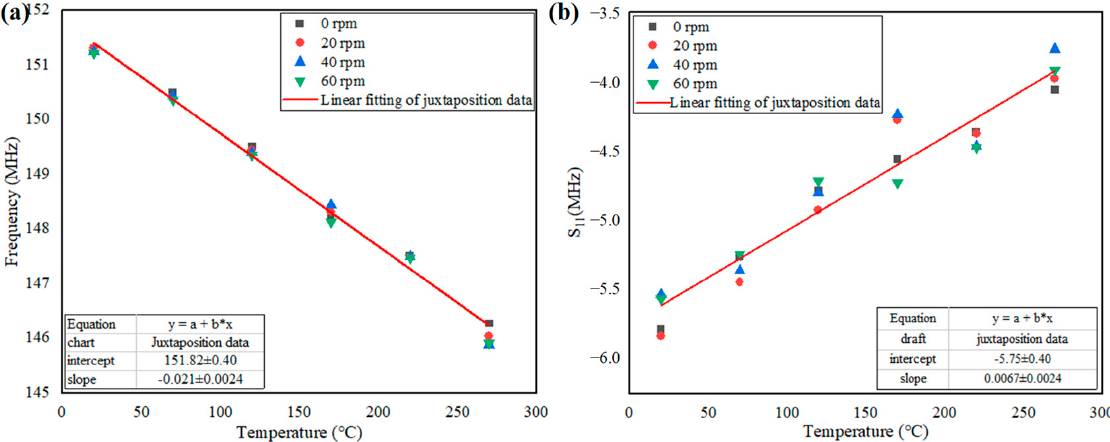
Figure 7. ( a ) Frequency at different speeds versus temperature; ( b ) frequency variation with temperature at different speeds.